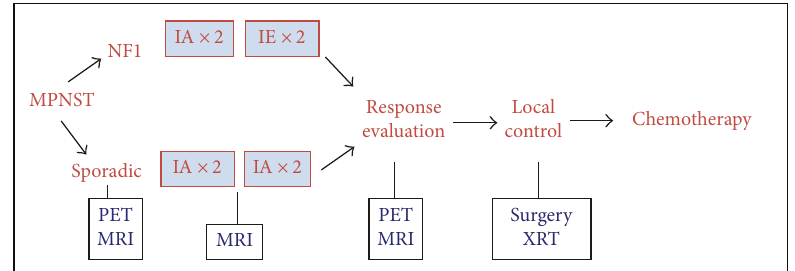
Figure 1: Trial design and treatment